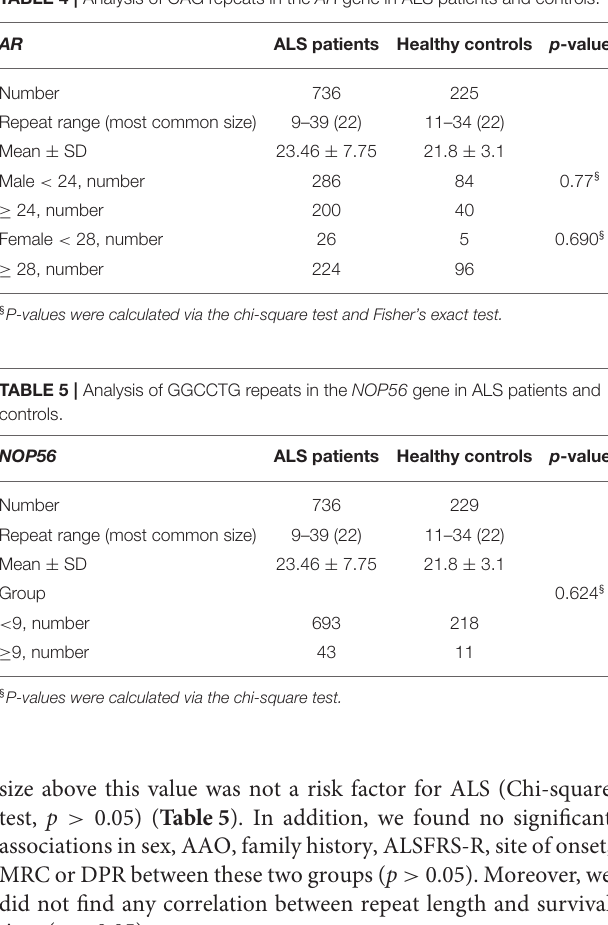
TABLE 4 | Analysis of CAG repeats in the AR gene in ALS patients and controls.